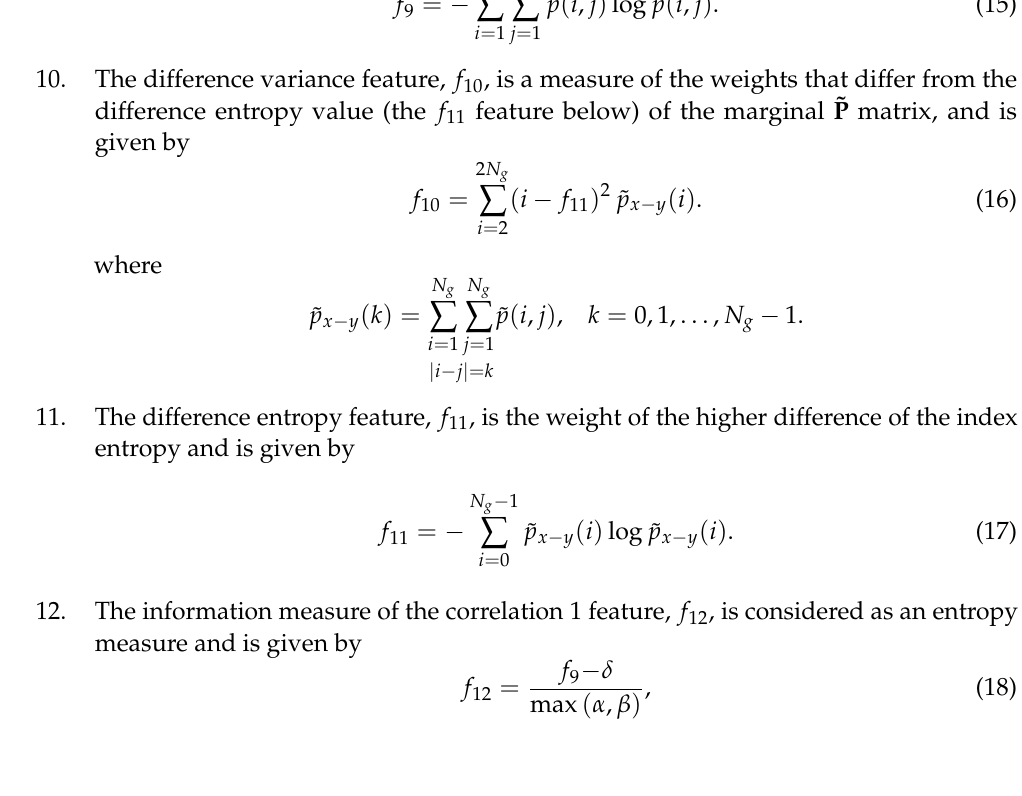
Since log ( 0 ) is undefined, whenever a 0 probability is encountered during the compu- tations, it should be replaced by an arbitrarily small positive value. 9. The entropy feature, f 9 , is a concept of information theory, estimating the randomness of pixel intensities in the image. As such, its value is zero for a constant image. It is given by